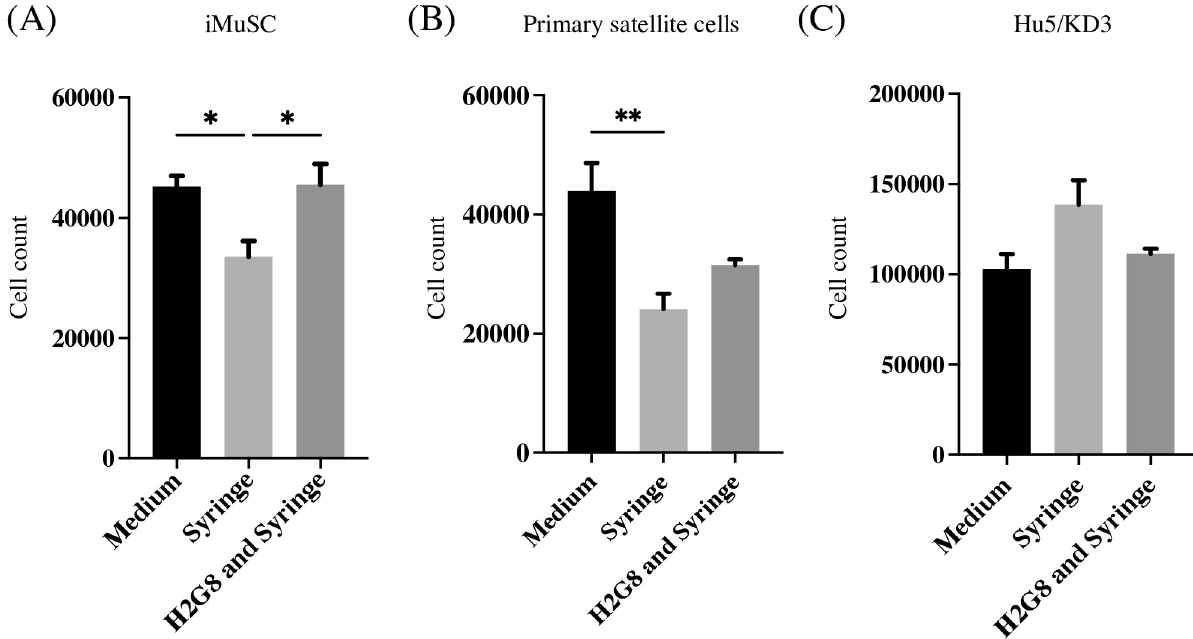
Fig 5. H2G8 increases the proliferation of iMuSCs. (A) Number of iMuSCs 3 days after passage. The seeding cell number was 1.5 x 10 4 cells/well. ‘Syringe’ describes cells passaged after passing through the needle; ‘H2G8 and Syringe’ describes cells passaged after passing through the needle with H2G8; and ‘Medium’ describes cells passaged without passing through the needle. (B) Number of mouse primary satellite cells 3 days after passage. The seeding cell number was 2.1 x 10 4 cells/well. (C) Number of Hu5/KD3 cells 3 days after passage. The seeding cell number was 2.1 x 10 4 cells/well. Data show the mean ± SEM (ANOVA with Tukey’s multiple comparison test). � p < 0.05, �� p < 0.1; n =